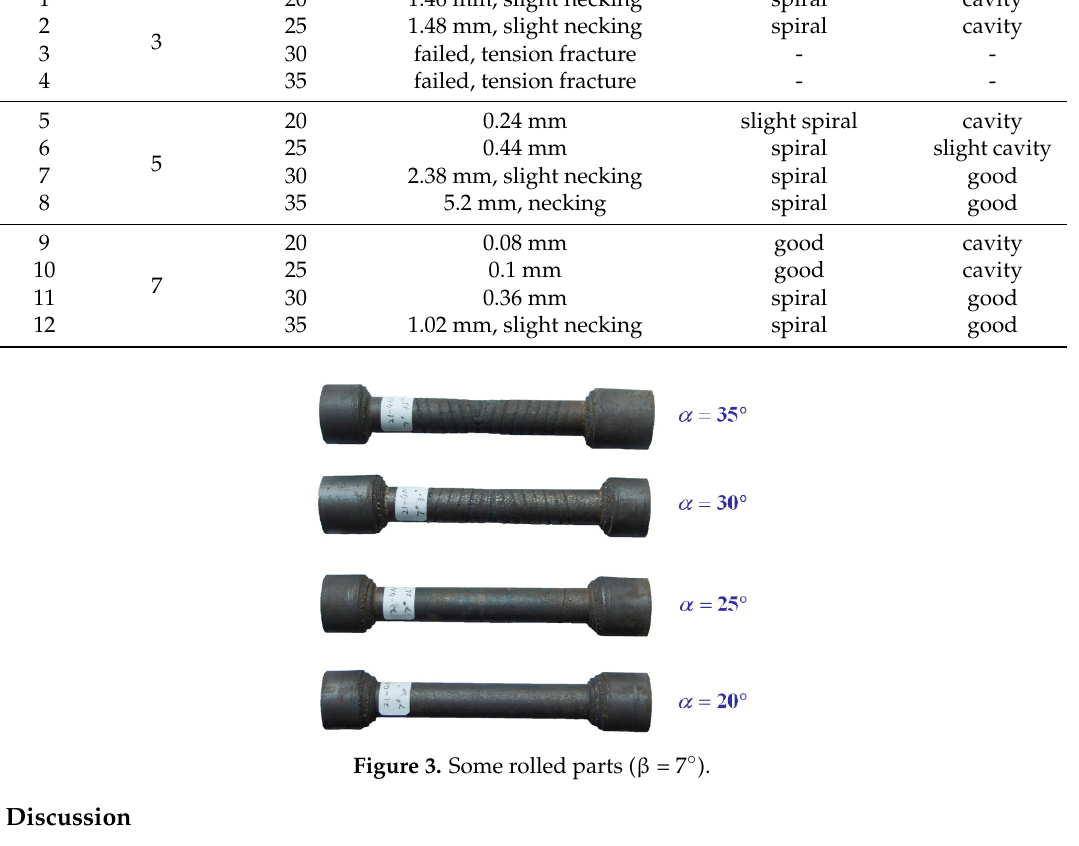
Figure 4. Positions of Diameters measured.